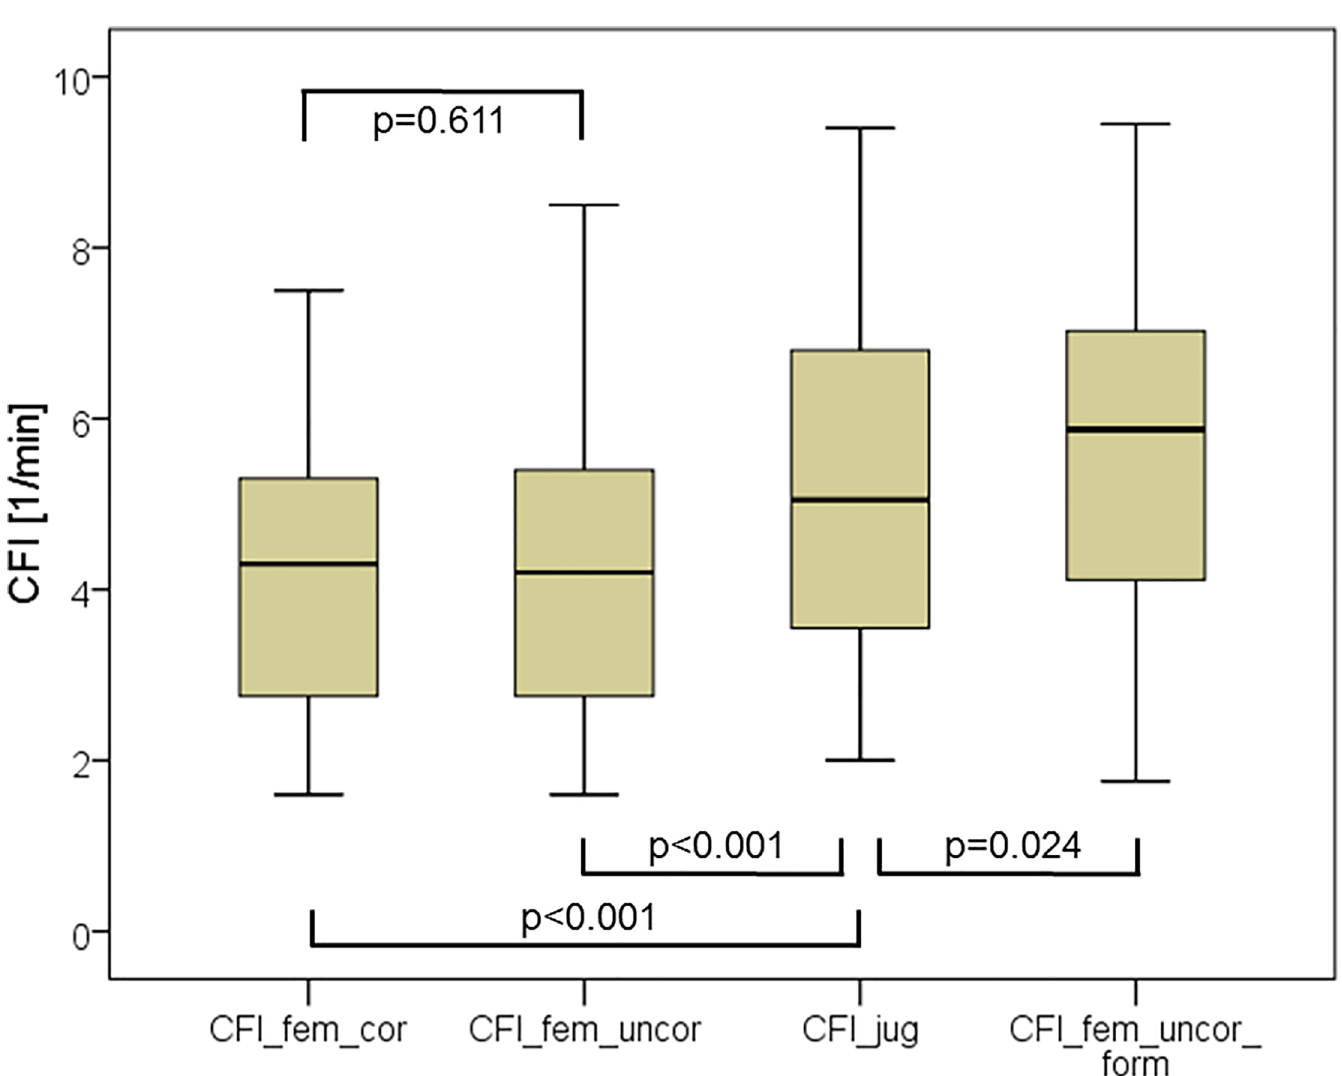
Fig 1. Boxplots plots comparing cardiac function index (CFI) derived from jugular indicator injection (CFI_jug), from femoral injection without activation of a potential correction by the device (CFI_fem_uncor), from femoral injection with activation of a potential correction by the device (CFI_fem_cor) and from femoral injection without activation of a potential correction by the device, but corrected by the previously suggested formula (CFI_fem_uncor_form). CFI_fem_uncor_form was corrected using the formula suggested for correction of femoral indicator injection derived GEDVI: GEDVI corrected [ml/m 2 ] = 0.539 (cid:3) GEDVI uncorrected —15.17 + 24.49 (cid:3) CI uncorrected 2.311 (cid:3) BW ideal. CFI_fem_uncor_form was calculated by multiplying CFI_fem_uncor with the ratio GEDV uncorrected / GEDV corrected . GEDV(I): global end-diastolic volume